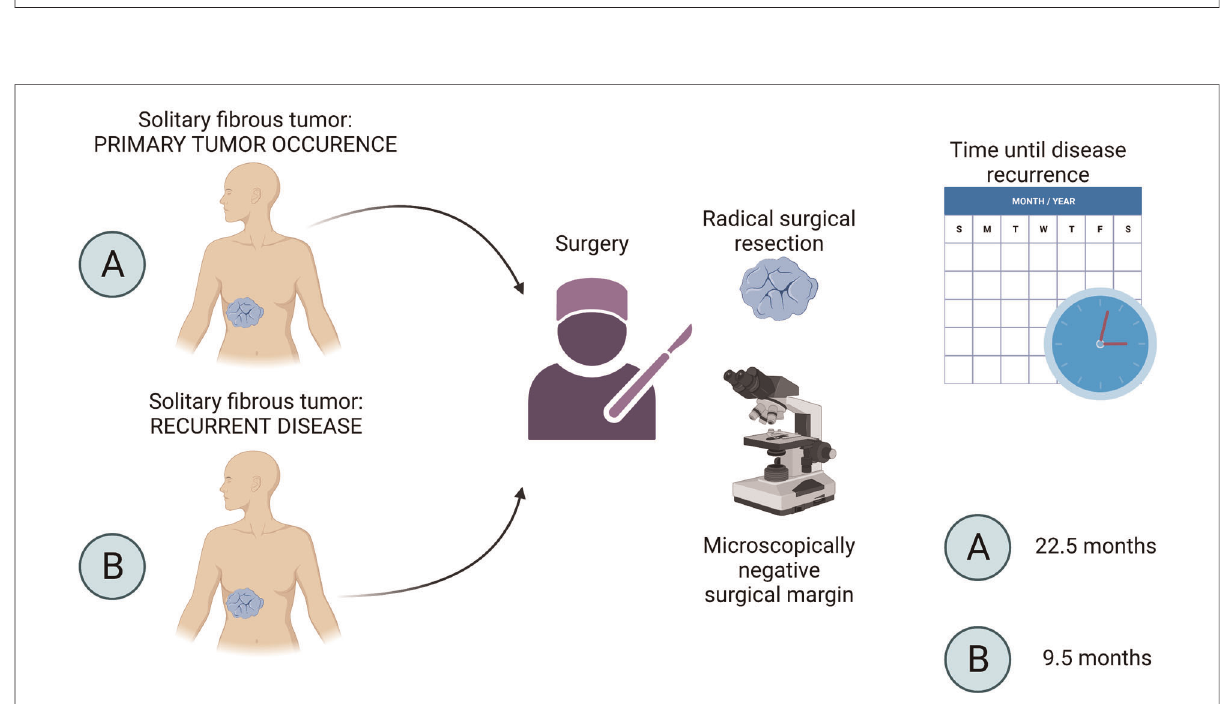
FIGURE 4 Time until disease recurrence. Patients with recurrent SFT ( B ) tended to relapse earlier (median 9.5 months, ranging from 5 to 19 months) than patients operated on for newly diagnosed SFT ( A ). The median time until disease recurrence in ( A ) patients was 22.5 months. SFT, solitary fi brous